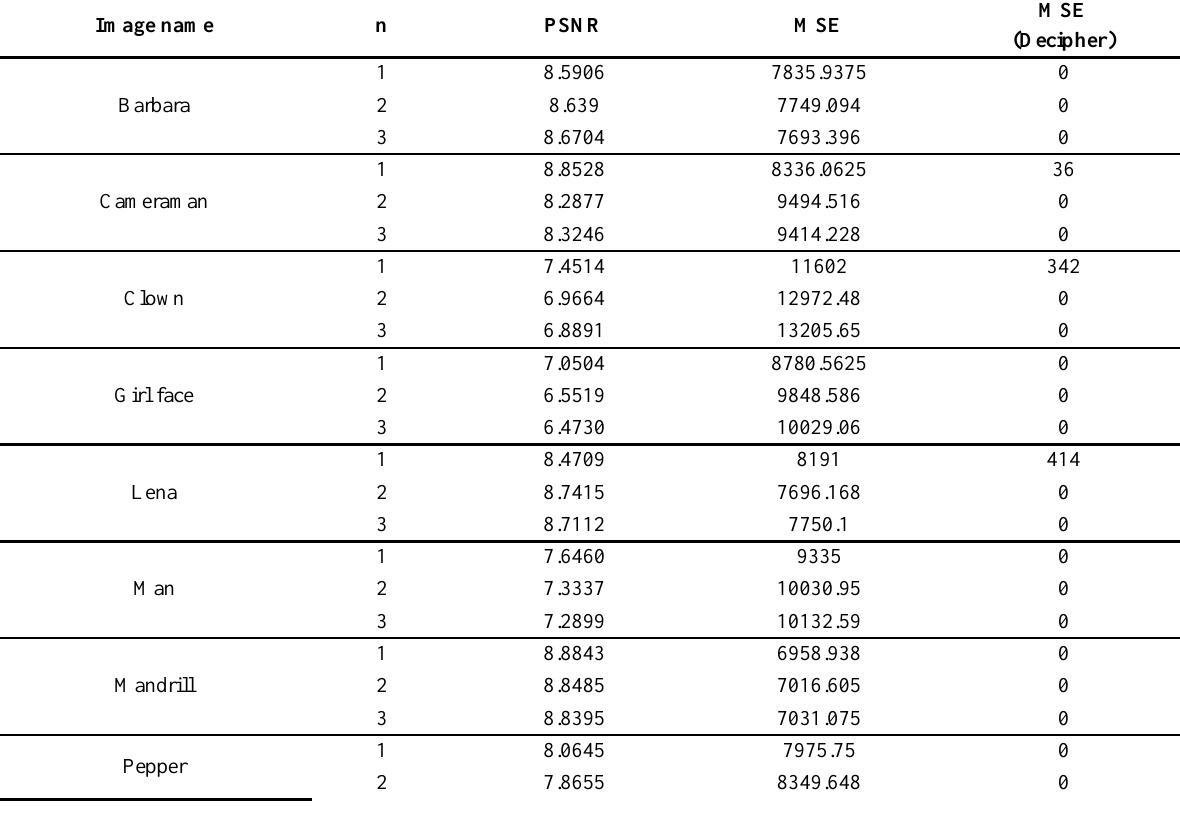
Table 4. The PSNR and MSE analysis of the proposed